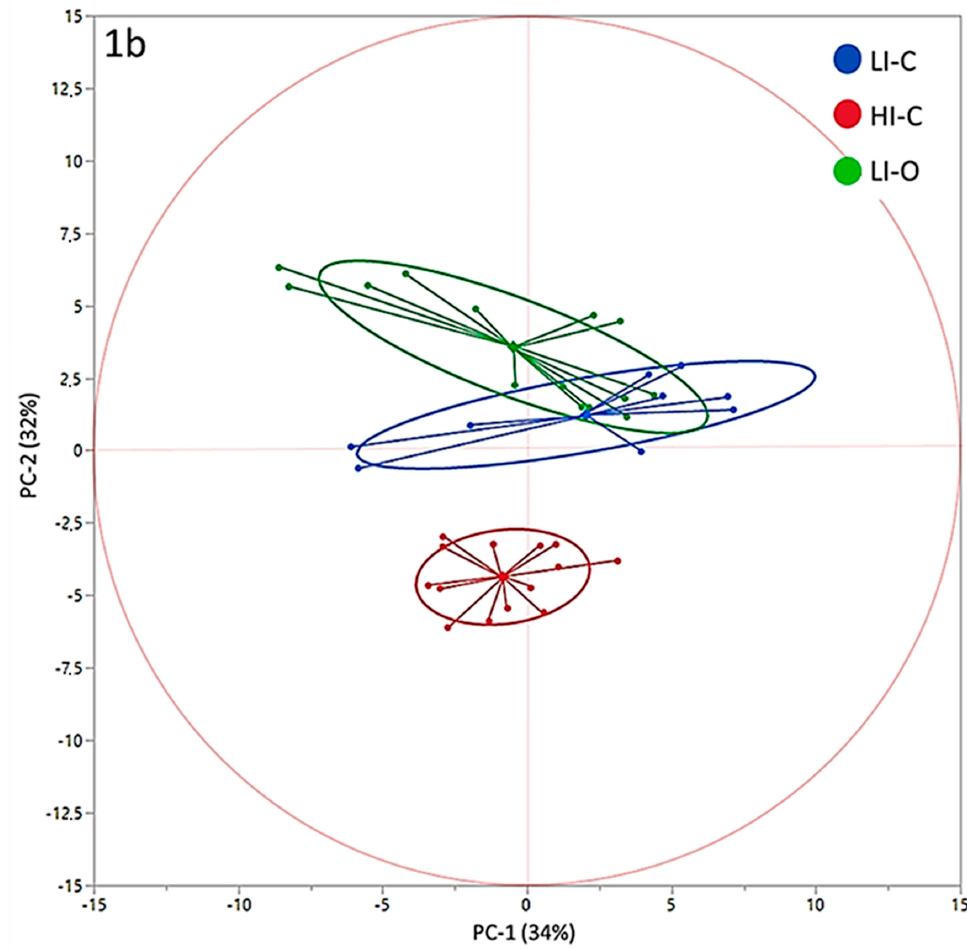
Figure 1. Principal Component Analysis Loadings Plot ( a ) and Scores Plot ( b ). a, b, c = values in the same row that have different superscript are significantly different at p ≤ 0.05, ANOVA and Student- Newman-Keuls post-hoc test.